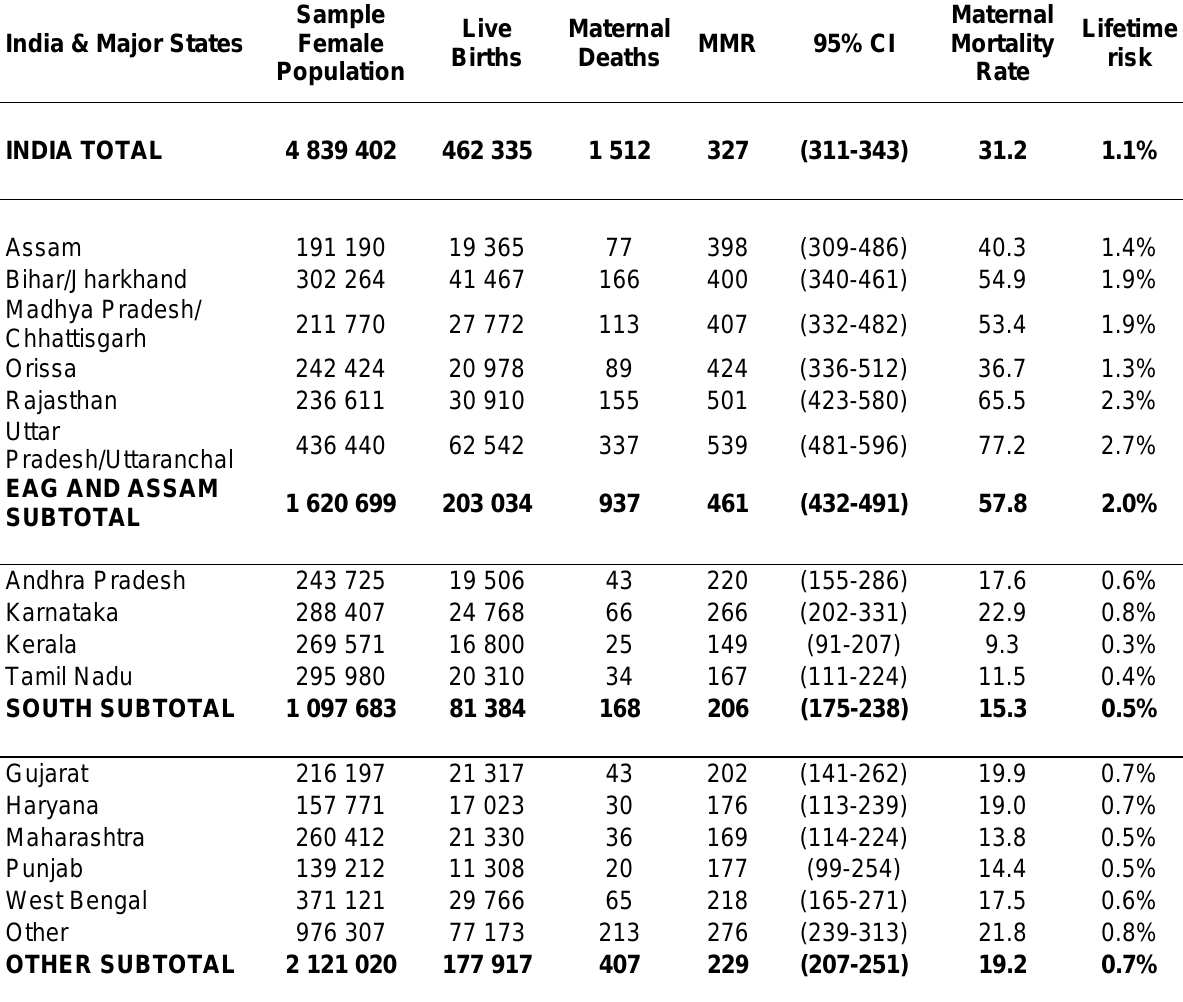
Table 2: Live Births, Maternal Deaths, Maternal Mortality Ratio in India by State from 1999-2001 SRS Prospective Household Reports India & Major